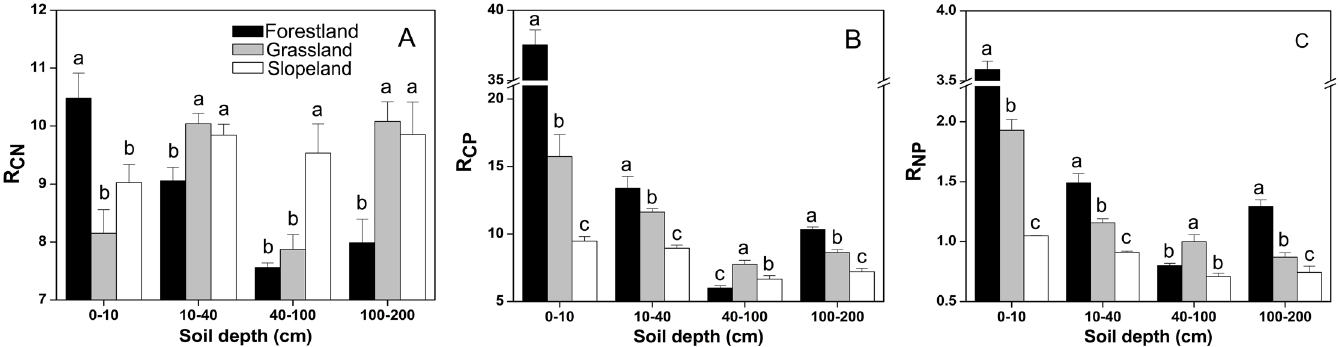
Fig 4. Distribution of R CN (A), R CP (B) and R NP (C) in soil at depths of 0 – 10 cm, 10 – 40 cm, 40 – 100 cm and 100 – 200 cm. The error bars are the standard errors. Different lowercase letters indicate significant differences at 0.05 (P < 0.05) levels among the different land use types within the same soil